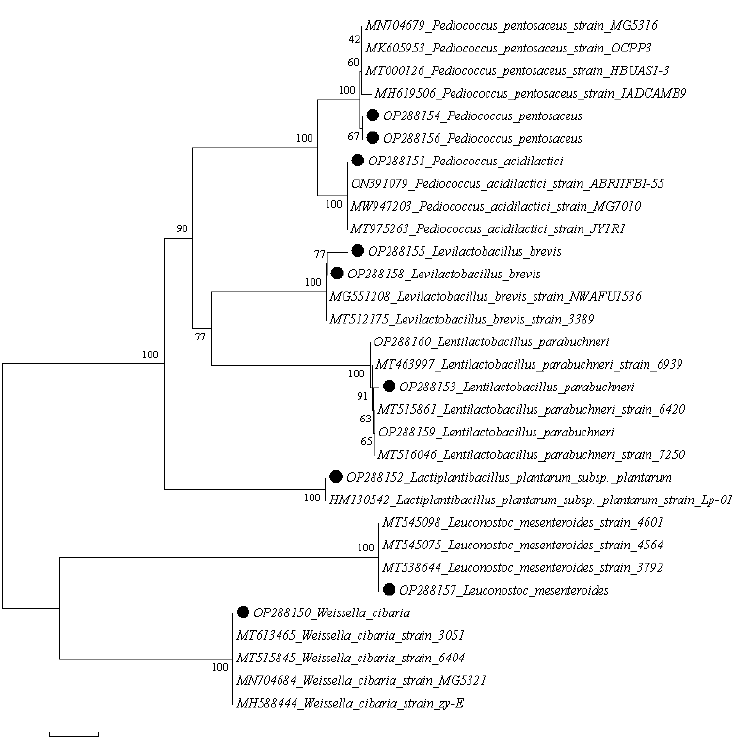
Figure 3. Phylogenetic tree based on 16S rRNA gene sequences analysis. Solid circles represent strains isolated from fermented grains of Baijiu.